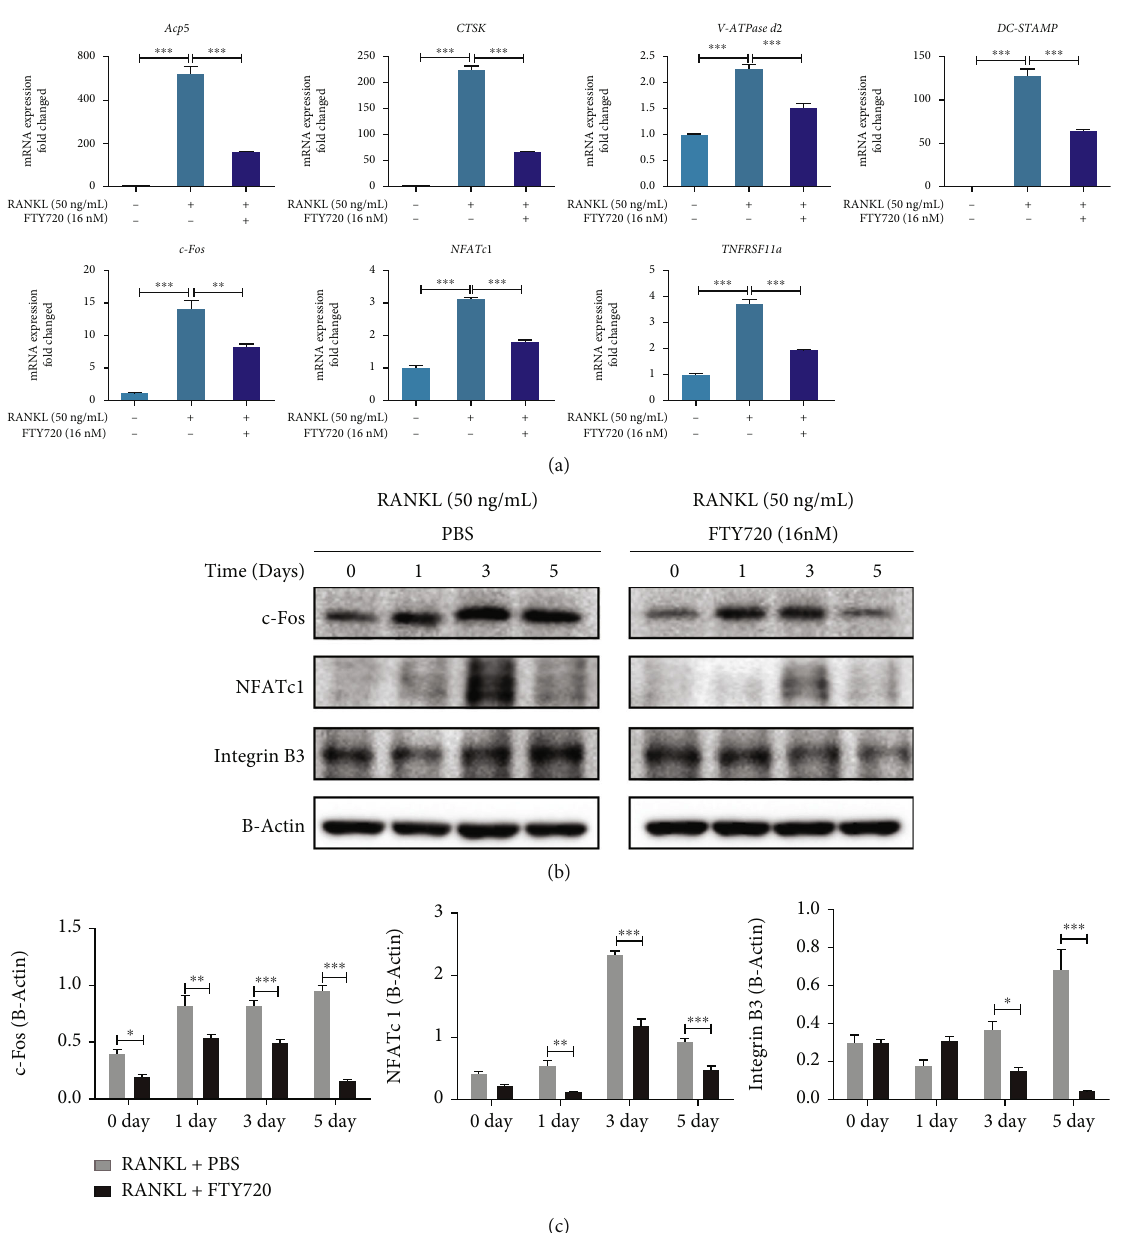
Figure 2: FTY720 downregulates the expression of osteoclast- (OC-) related genes. (a) RT – qPCR detection of the mRNA expression of OC- related genes, including tartrate-resistant acid phosphatase 5 (Acp5), recombinant human cathepsin K (CTSK), vacuolar ATPase d2 (V- ATPase d2), dendritic cell-speci fi c transmembrane protein (DC-STAMP), c-Fos, nuclear factor of activated T cells c1 (NFATc1), and tumor necrosis factor receptor superfamily member 11a (TNFRSF11a). 18s was selected as the control gene for the experiments ( n = 3 ). (b) Western blotting of RANKL- (50 ng/mL) induced expression of c-Fos, NFATc1, and Integrin B3 on days 0, 1, 3, and 5 in the presence or absence of FTY720 (16 nM). B-Actin was selected as the control protein. (c) Quantitative statistics of the grayscale values of the c-Fos, NFATc1, and Integrin B3 protein bands ( n = 3 ). Data are expressed as the mean ± SEM . ∗ P < 0 : 05 , ∗∗ P < 0 : 01 , ∗∗∗ P < 0 : 001 by one-way ANOVA with Tukey ’ s post hoc test (a) or two-way ANOVA with Bonserroni ’ s post hoc test